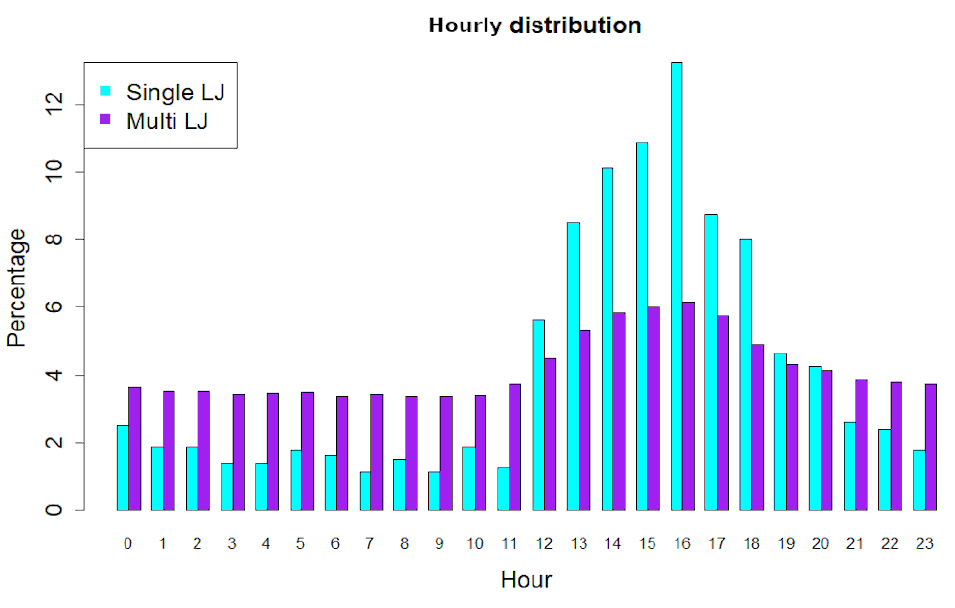
Figure 8. Hourly distributions (in percentage) of the SLJsts (cyan) and MLJsts (purple). Considering the two levels of the LJs, the first associated with the detection of multiple sources of flashes (occurring in thunderstorms producing small hail, moderate wind gusts, or intense rainfalls) and the second linked to the single sources of the lightning in severe thunderstorms (the ones producing tornadoes, large hail, or strong wind gusts), Figure 9 presents which is the highest level of an LJ in SLJsts and MLJsts, respectively. In the case of MLJsts, a value of two does not mean that jumps of this level only have occurred. MLJsts usually produce both levels of LJs. In any case, SLJsts are more prone to give Level 1 jumps, while the contrary occurs in MLJsts. In this way, deeper convective thunderstorms will produce more than one LJ and at least one of Level 2 also.